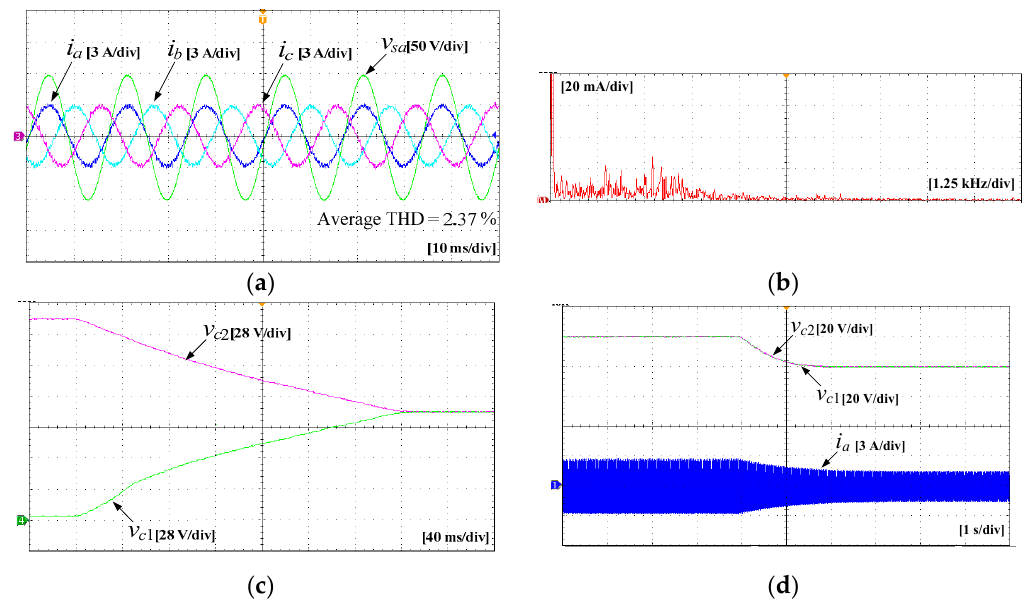
Figure 6. Experimental results of the proposed predictive control method with no weighting factor (a) three-phase input currents and a -phase input voltage ( b ) frequency spectrum of input current (c) capacitor voltages and line-to-line rectifier voltage (c) capacitor voltages balancing under voltage unbalanced condition (d) capacitor voltages and input current with step change of reference output voltage from 200 to 160 V.